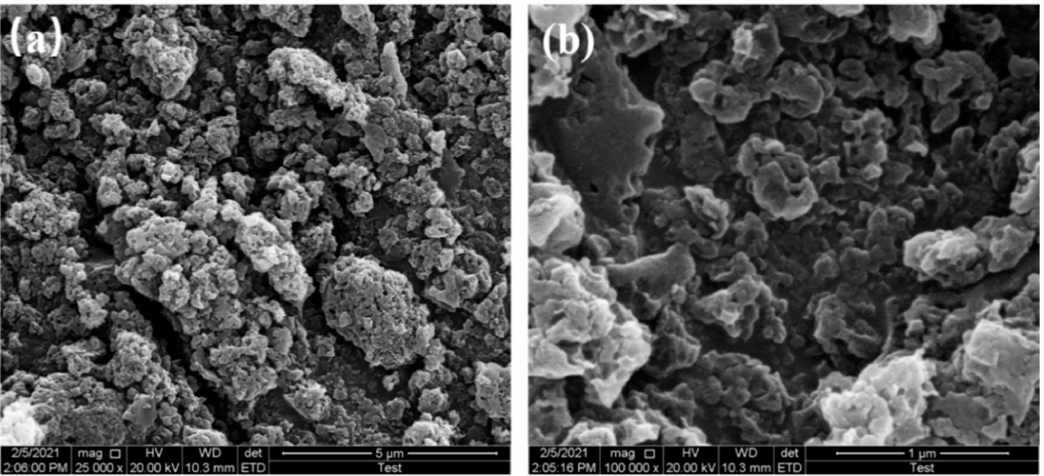
Figure 4. SEM images of 650 ◦ C at ( a ) 5 µ m resolution, ( b ) 1 µ m resolution.